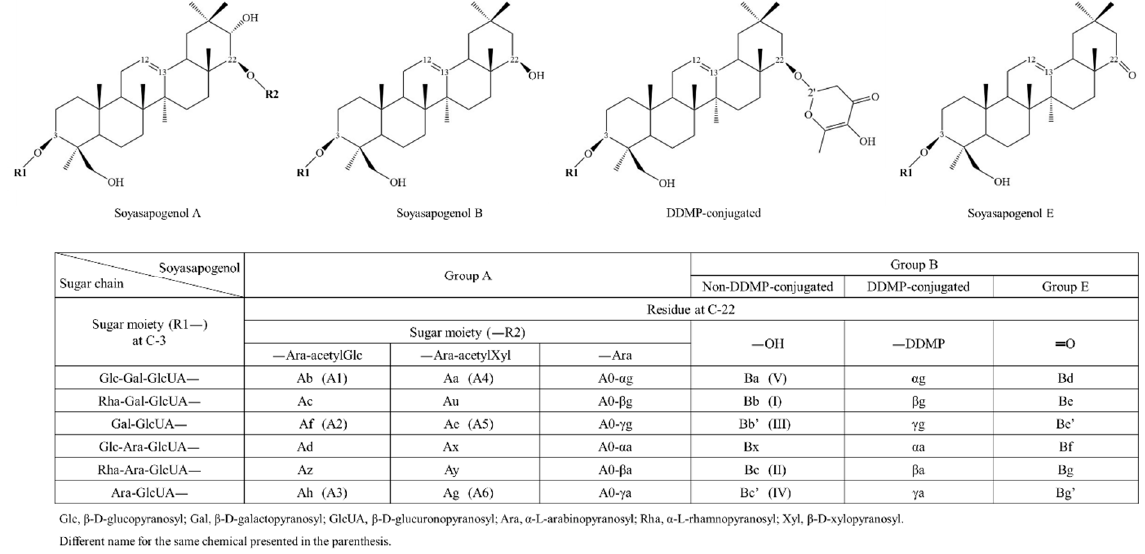
Figure 3. Chemical structure and nomenclature of soyasaponins (adapted from the literature with minor modifications [73,74]).